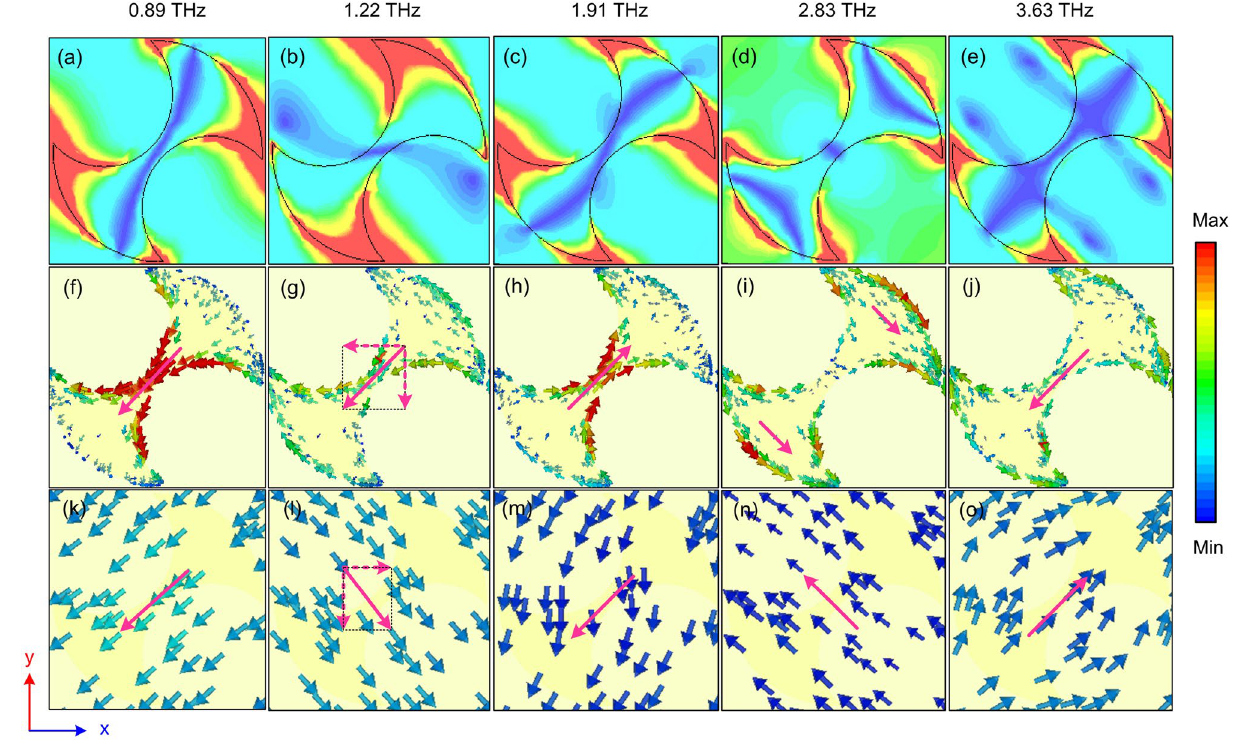
Figure 15. The distributes of ( a–e ) electric field, ( f–j ) the top surface current, and ( k–o ) the bottom surface current of the proposed RMS for PC mode at various resonant frequencies.